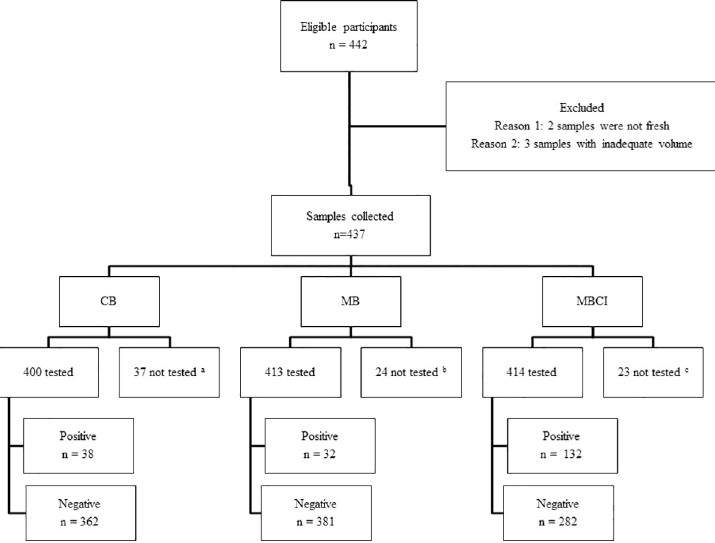
Fig 4. Study participants’ flow chart. a Thirty-seven participants did not provide enough stool specimens to perform CB; b Twenty-four participants did not provide enough stool specimens to perform MB; c Twenty-three participants did not provide enough stool specimens to perform